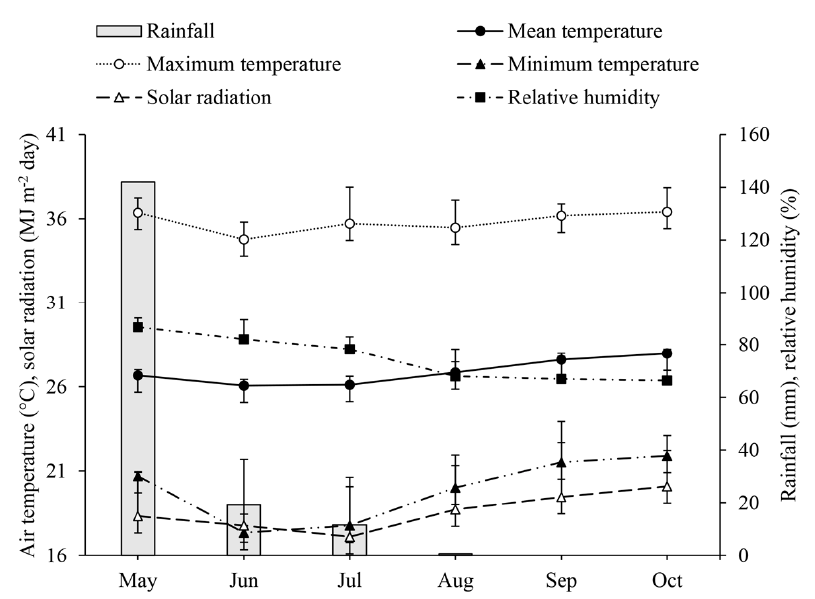
Figure 1. Mean values of air temperature (°C), solar radiation (MJ m − 2 day), relative humidity (%), and rainfall (mm) in the experimental area of C. maxima from May to October in Mossoró in 2020. Sources: Estação Meteorological Automatic INMET and the pluviometer of the Fazenda Experimental Rafael Fernandes (UFERSA).